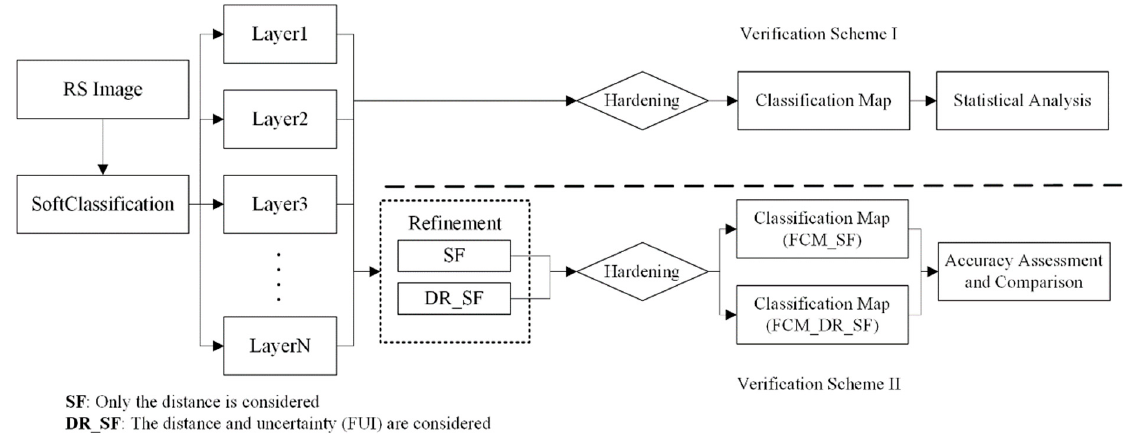
Figure 5. Flowcharts of two verification schemes (LayerN represents the probability map that the image is classified into the N -th class in the soft classification results, and “Hardening” represents the hardening process of soft classification results based on the principle of maximum membership). DR_SF, Distance and Reliability-based Spatial Filtering; SF, Spatial Filtering; FCM, Final Classification Map.